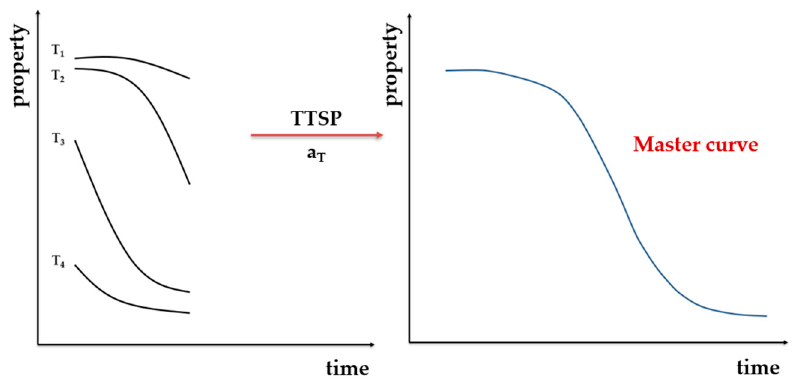
Figure 5. Schematic illustration of creating a master curve through the time–temperature superposition (TTSP) method [92].